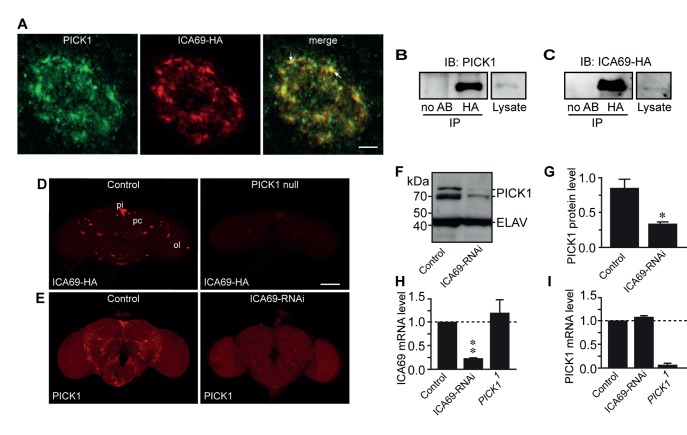
Interdependent expression of PICK1 and ICA69 in Drosophila.(A) Immunostainings for ICA69 and PICK1 in a single peptidergic neuron in the protocerebrum of adult Drosophila brain. HA-tagged ICA69 targeted to peptidergic cells (c929-GAL4/+; UAS-ICA69-HA/+) was detected in parallel with endogenous PICK1. Arrows indicate examples of PICK1/ICA69 co-localization. Scale bar, 10 µm. (B and C) Drosophila ICA69-HA co-immunoprecipitates PICK1 from fly head extracts. Flies were co-expressing ICA69-HA and PICK1 under the pan-neuronal elav-GAL4 driver (elav-GAL4/+; UAS-ICA69-HA/UAS-PICK1A). (B) Immunoprecipitation (IP) with anti-HA antibody and immunoblotting (IB) with anti-PICK1 antibody. Left lane, control without antibody; right lane, lysate. (C) Immunoprecipitation (IP) with rat anti-HA antibody (3F10) and immunoblotting (IB) with mouse anti-HA (16B12) antibody. Left lane, control without antibody; right lane, lysate. (D) Dependence of ICA69 expression on PICK1 expression in Drosophila. ICA69-HA immunoreactivity is shown in control brain (c929-GAL4, PICK1/+; UAS-ICA69-HA/+) and in PICK1-null mutant brain (c929-GAL4, PICK1/PICK2; UAS-ICA69-HA/+). pi, pars intercerebralis; pc, protocerebrum; ol, optic lobe. Pictures are representative of six fly brains stained in three experiments. (E) Dependence of PICK1 expression on ICA69 expression in Drosophila. PICK1 immunosignal in control brain without RNAi transgene (ELAV-GAL4/UAS-DCR2;;TM3/+) and in brain with pan-neuronal expression of ICA69 hairpin RNA (ELAV-GAL4/UAS-DCR2;;UAS-ICA-RNAi/+) (ICA69-RNAi). Scale bar, 100 µm. Pictures are representative of six fly brains stained in three experiments. (F) Western blotting of head extracts from control and ICA69 RNAi flies. (G) Quantification of the data in (F). Protein levels are normalized to ELAV. Data are means ± SE, n = 6, p<0.05. (H and I) Quantification by RT-PCR of ICA69 mRNA (H) and PICK1 mRNA (I) levels in heads from ICA69 knockdown (ICA69-RNAi), PICK11, and control flies. Data are means ± SE, n = 6 for control and ICA69-RNAi, n = 4 for PICK11, *p<0.05, **p<0.01.